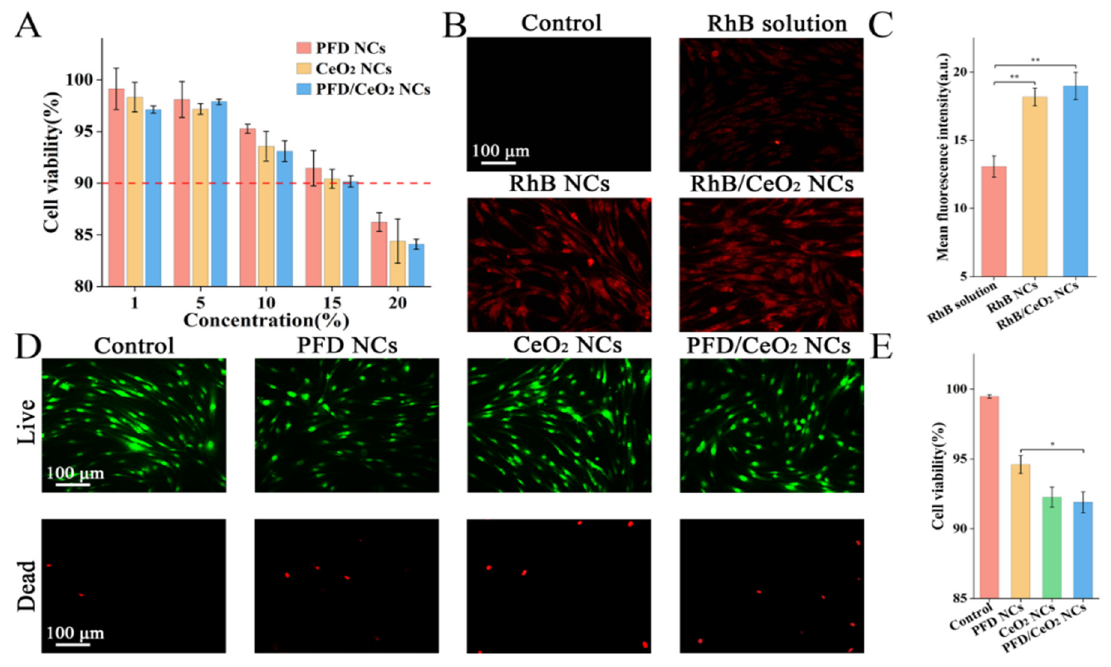
Figure 3. ( A ) Cell viability of CCK-8 assay in each group; ( B ) Fluorescence micrographs of cellular uptake assay in each group; ( C ) Mean fluorescence intensity of cellular uptake assay in each group; ( D ) Fluorescence micrographs of Live/dead assay in each group; ( E ) Cell viability of Live/dead assay in each group. (*, p < 0.05; **, p < 0.001)